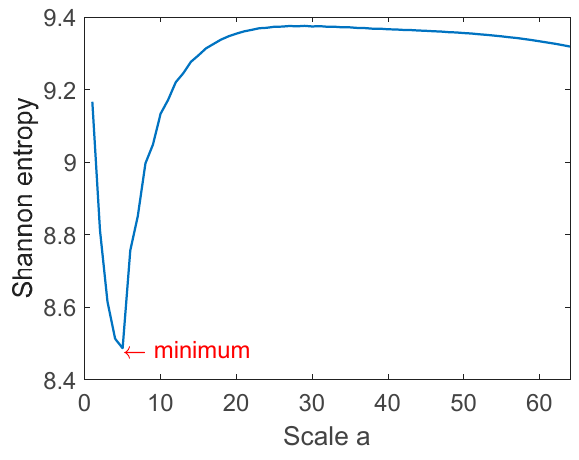
Figure 4. Shannon entropy values for each scale.